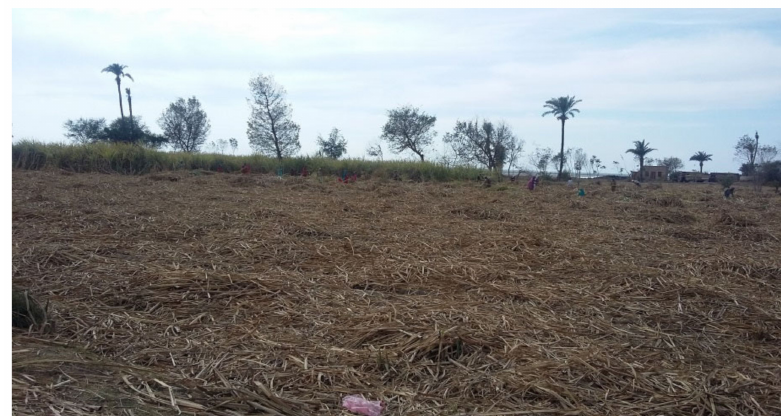
Figure 13. Men, women and children are cutting sugar-cane crop near the river in LN, district